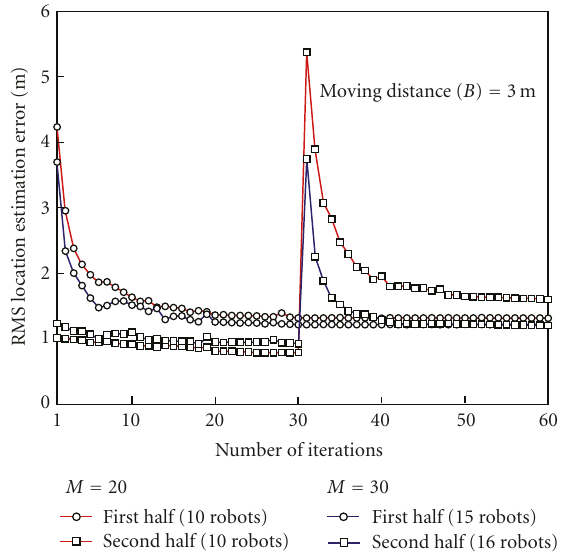
Figure 8: RMS location estimation error in the heading direction estimation.